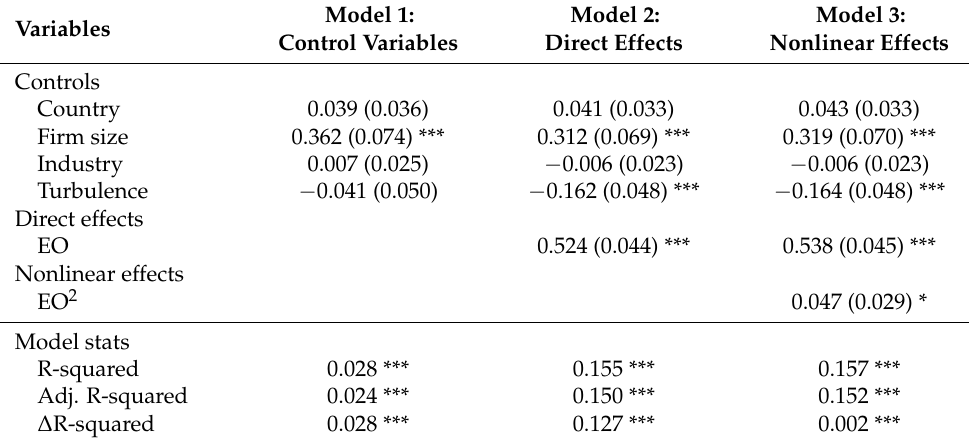
Table 3. Results of hierarchical regression analysis for sales growth (n = 963).